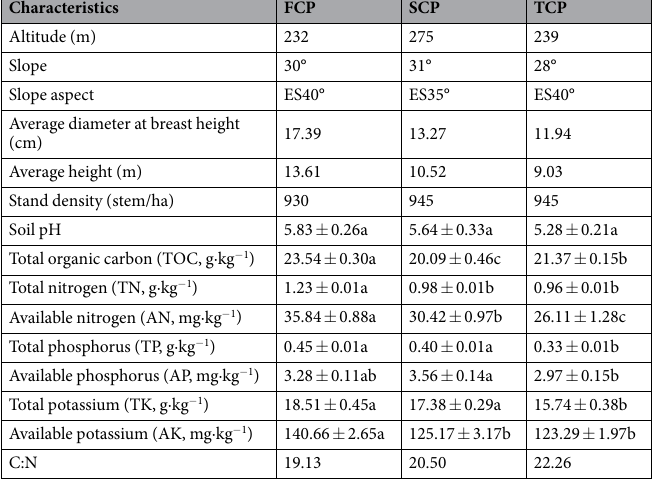
Table 1. Characteristics of experimental